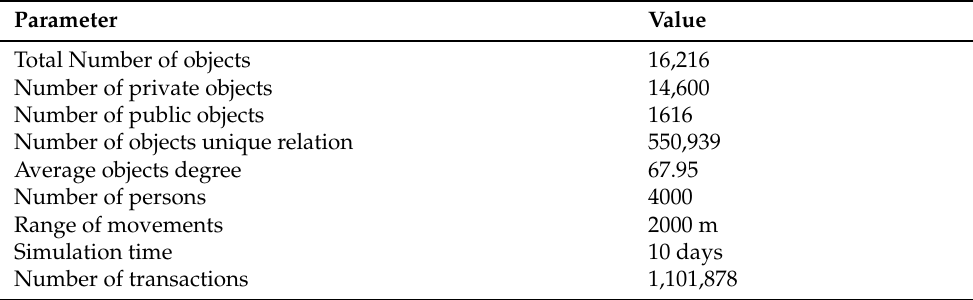
Table 3. Information about the dataset.